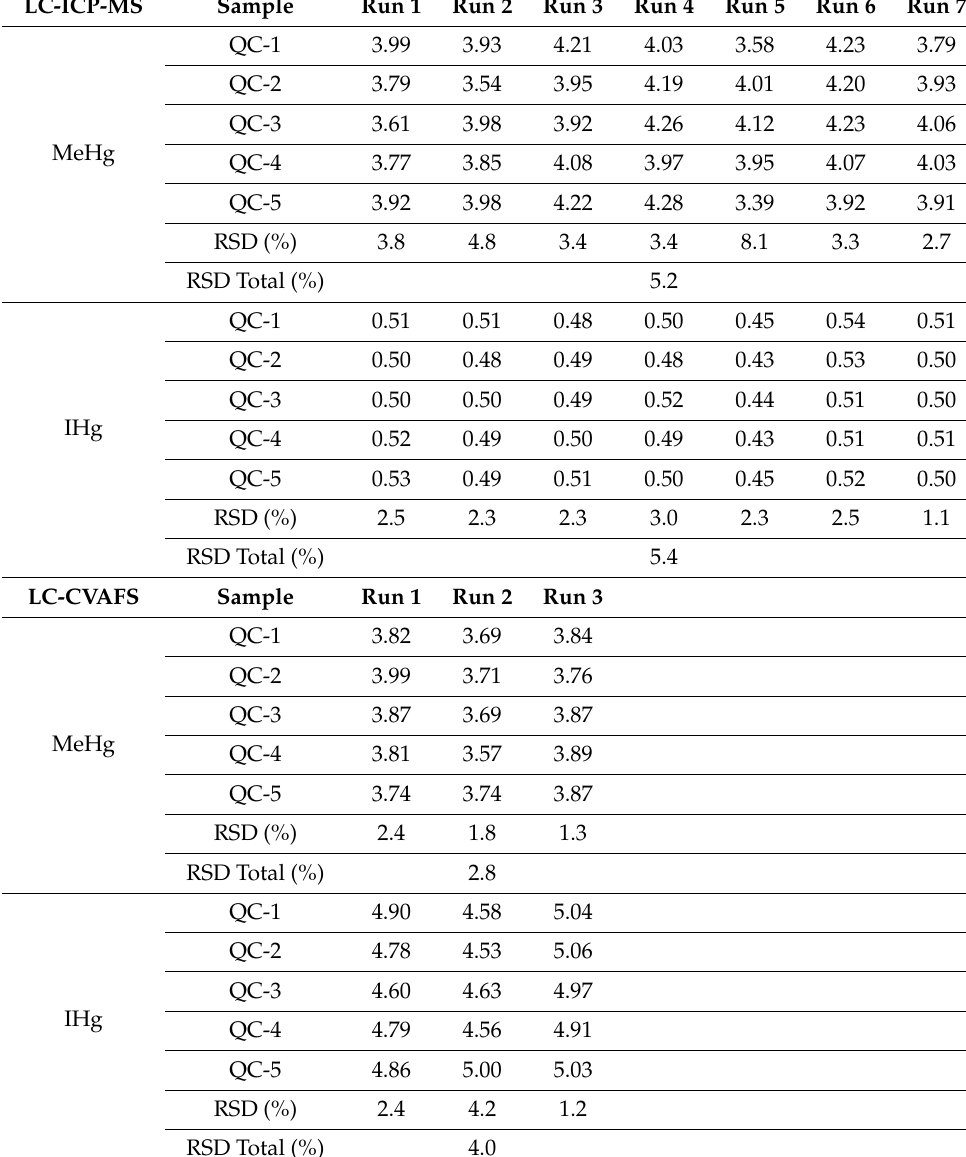
Table 3. Reproducibility: repeated measurements of standard middle concentration